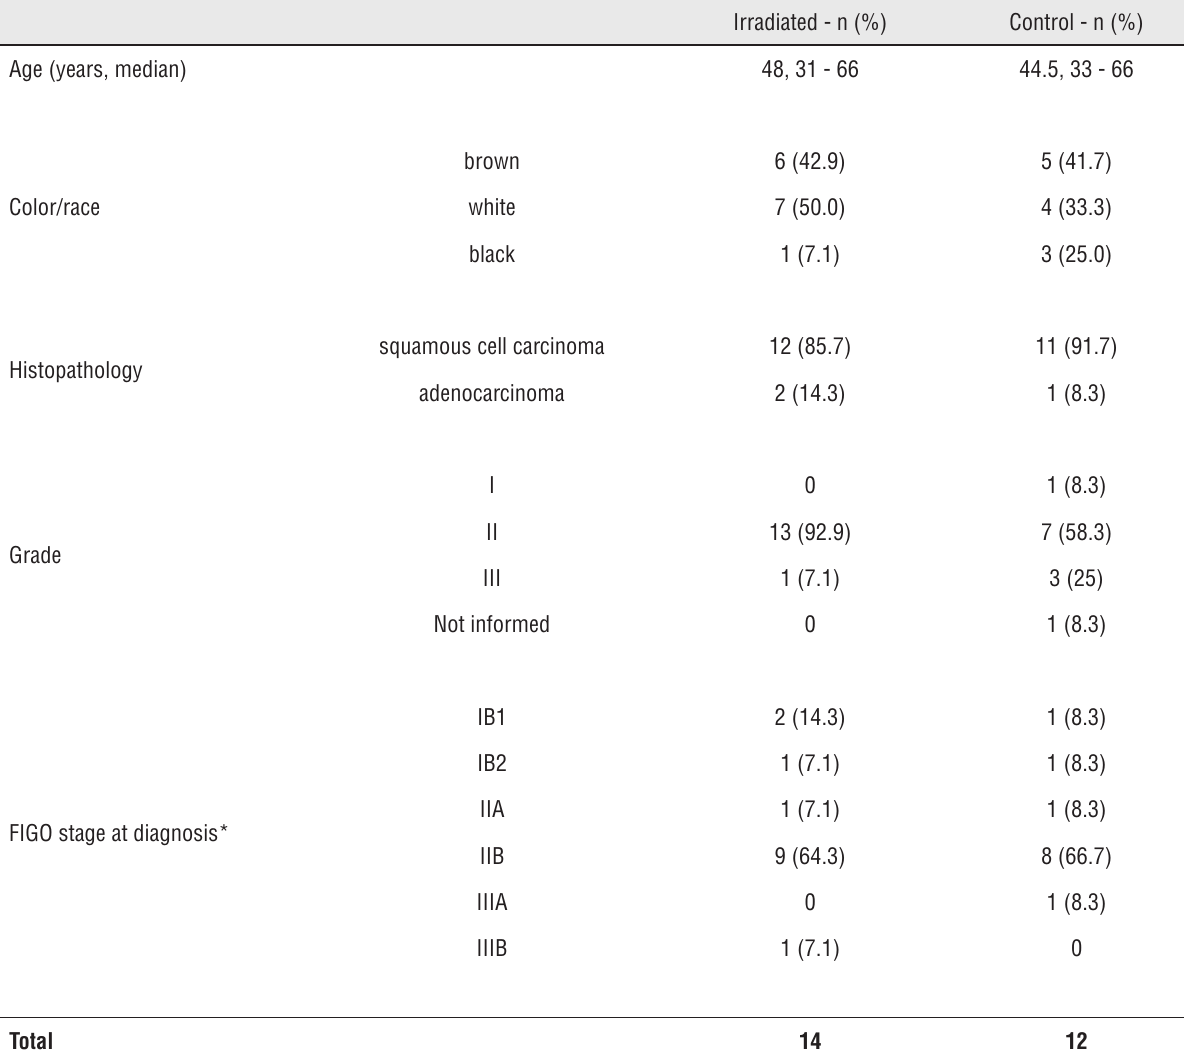
Table 1 - Clinical characteristics of patients.